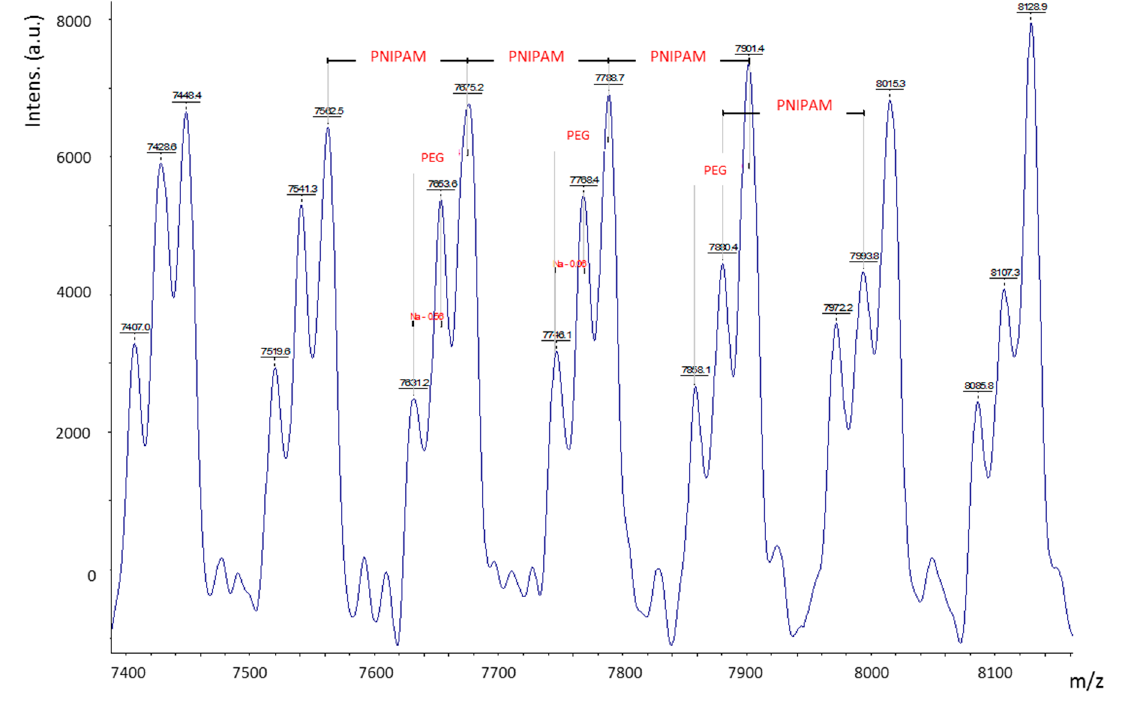
Figure 4. Section of the MALDI-ToF mass spectrum of the sortase A linked reaction product showing the presence of both poly(ethylene glycol) (PEG) and poly( N -isopropyl acrylamide) (PNIPAM) repeating units in the molecular ion series.